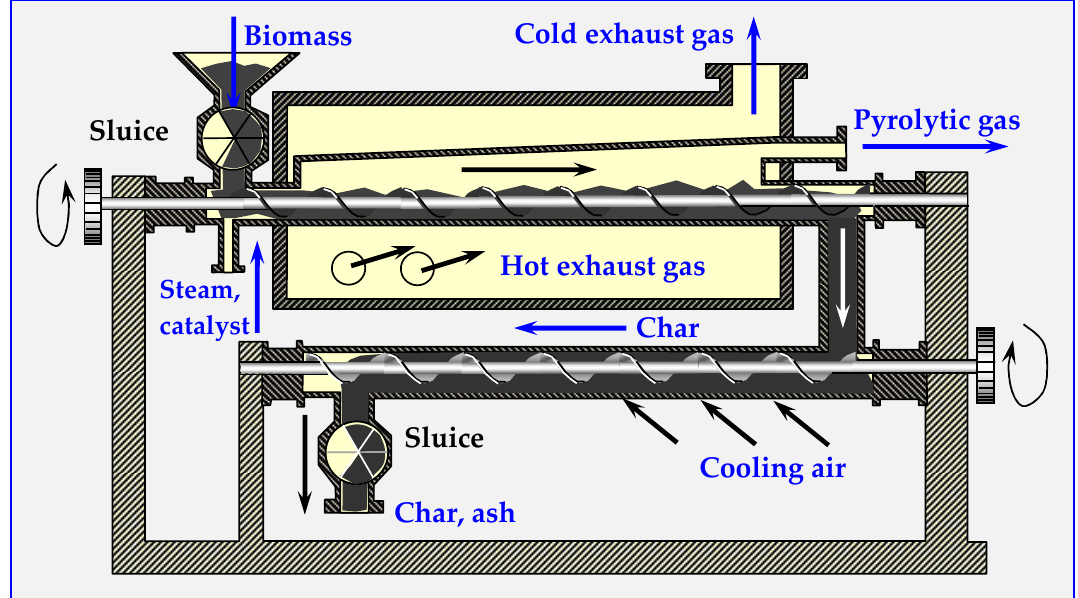
Figure 15. Diagram of a plate device for continuous thermal decomposition of biomass.